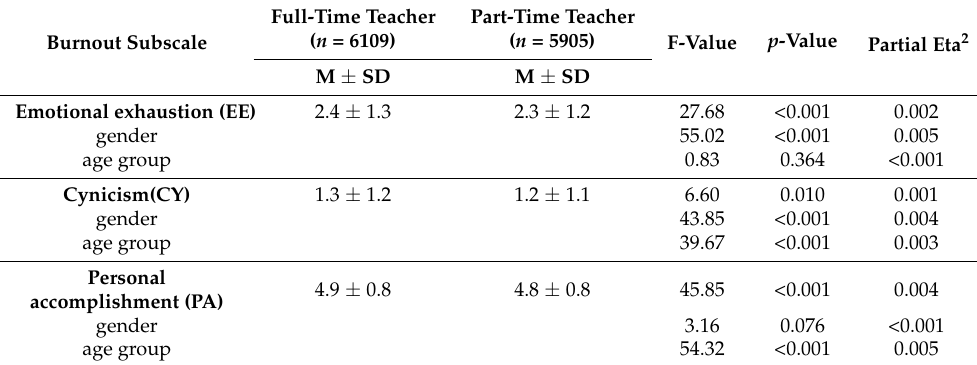
Table 2. Main effects of burnout subscales and covariates of full-time and part-time teachers. Full-Time Teacher ( n = Burnout Subscale